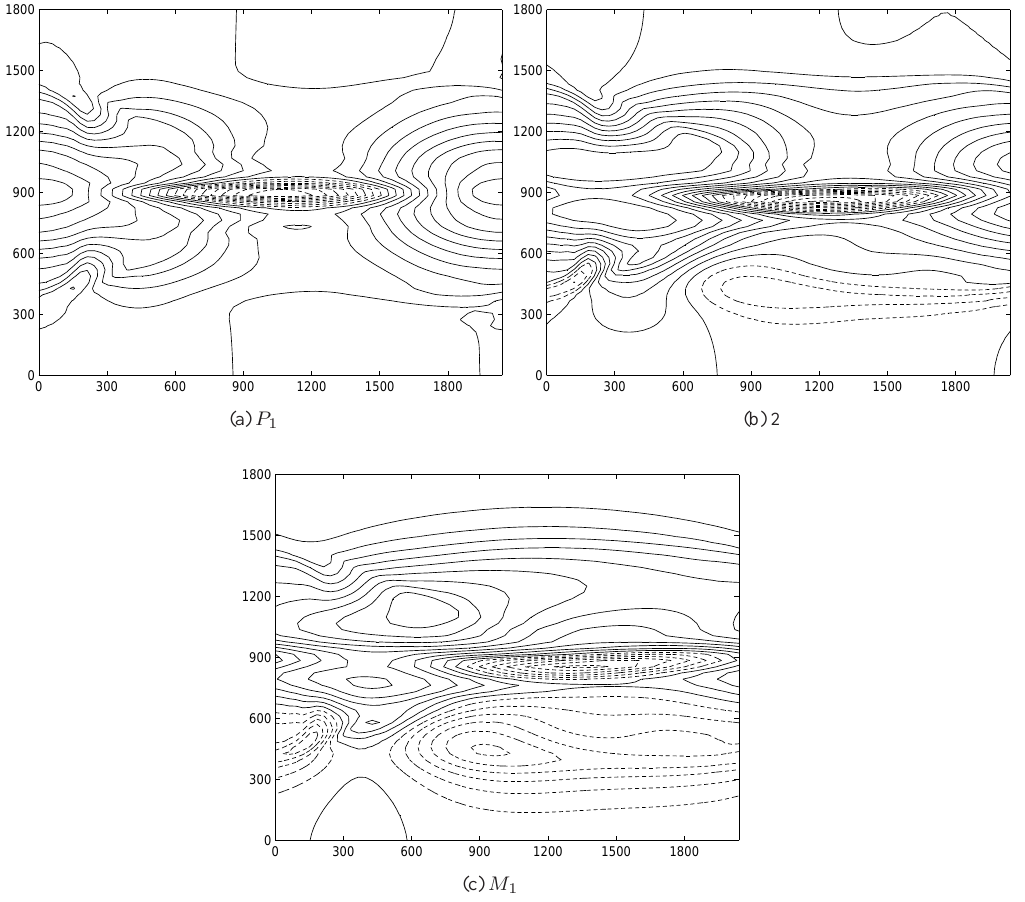
Fig. 9. Real eigenvectors corresponding to the points identified in Fig. 8: (a) pitchfork bifurcation P 1 ; (b) intermediate point 2; and (c) merging of two real eigenvalues into a complex conjugate pair at M 1 . Contours as in Fig. 6.